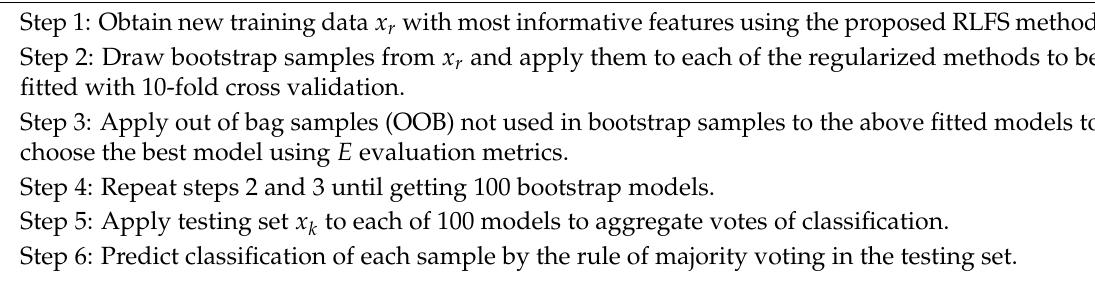
Algorithm 1 Proposed